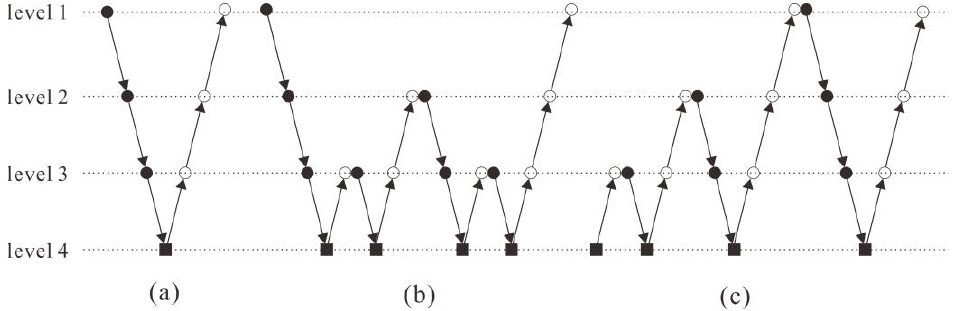
Figure 1. Multigrid structures. ( a ) V-cycle; ( b ) W-cycle; ( c ) FMV-cycle. ( ⚫ denotes pre-smoothing, denotes post-smoothing, ◼ denotes exact solver, denotes restriction, denotes prolongation). Algorithm 1. V-cycle multigrid method for the solution of A e = b : MG(A k , e k , b k , k )